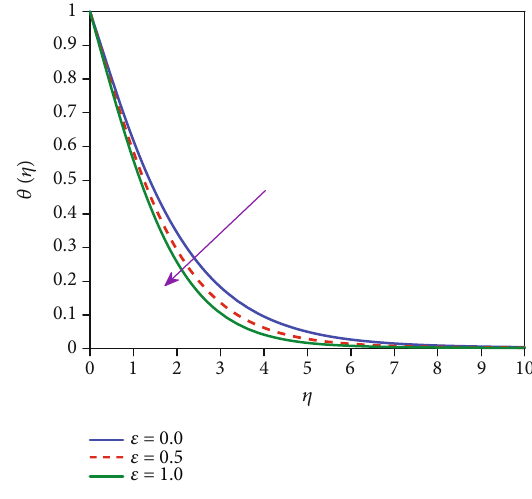
Figure 4: E ff ect of ε on the temperature θ ð η Þ .